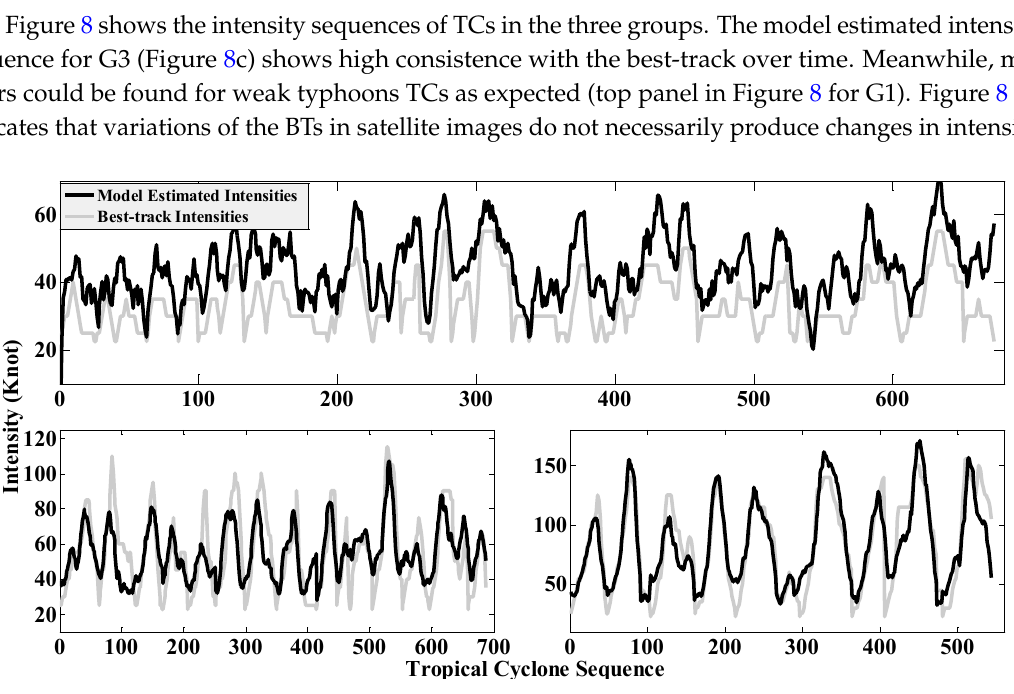
12-h smoothed (black solid line). The smoothed curve is consistent with the best-track curve ( R 2 of 0.91).